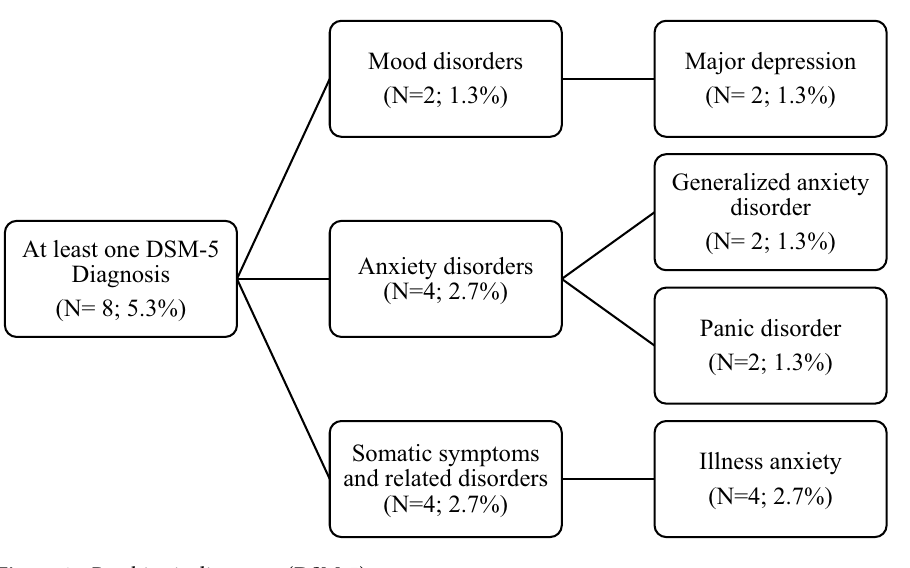
Figure 1. Psychiatric diagnoses